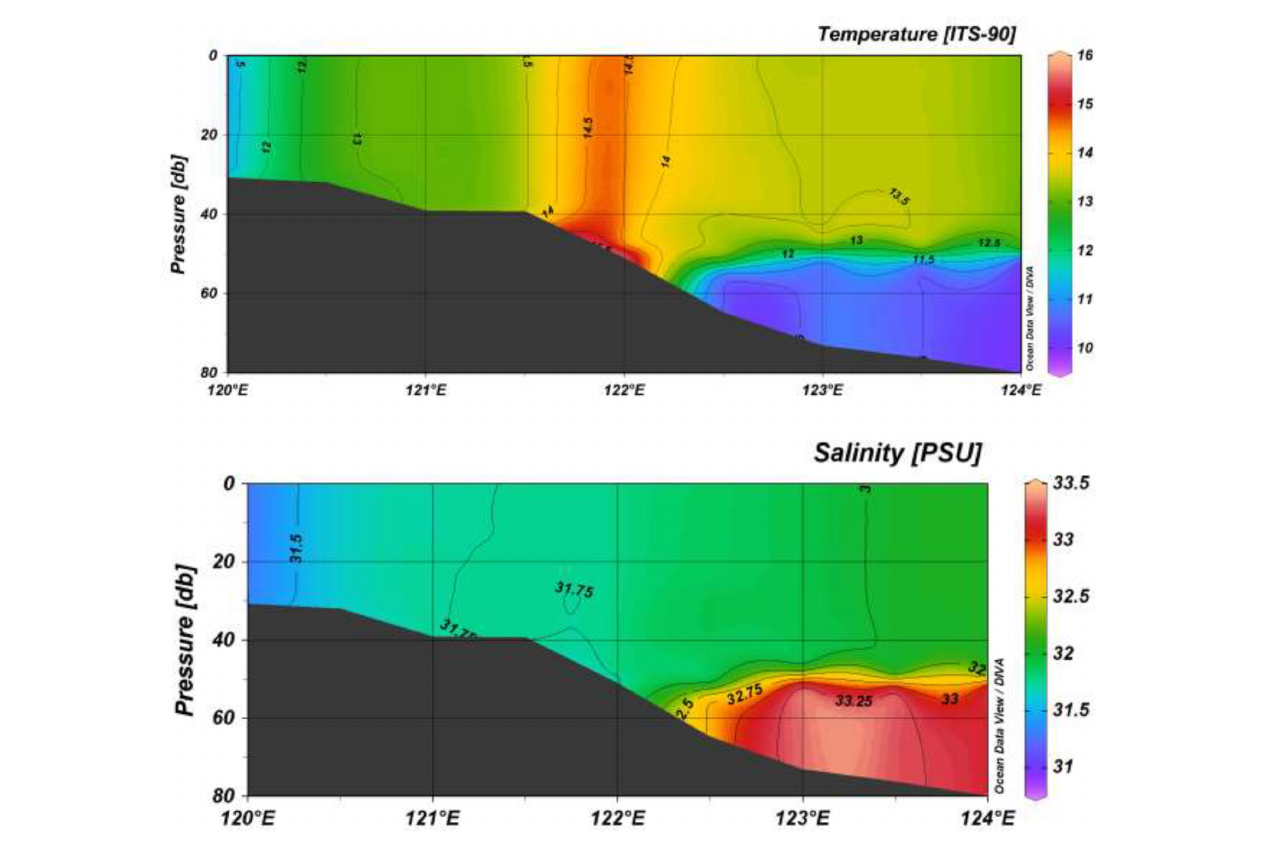
FIGURE 1 | Temperature and salinity distributions in the 35 ◦ N section of the southern Yellow Sea in December 2009 (the section was measured between December 6 and December 8, 2009).